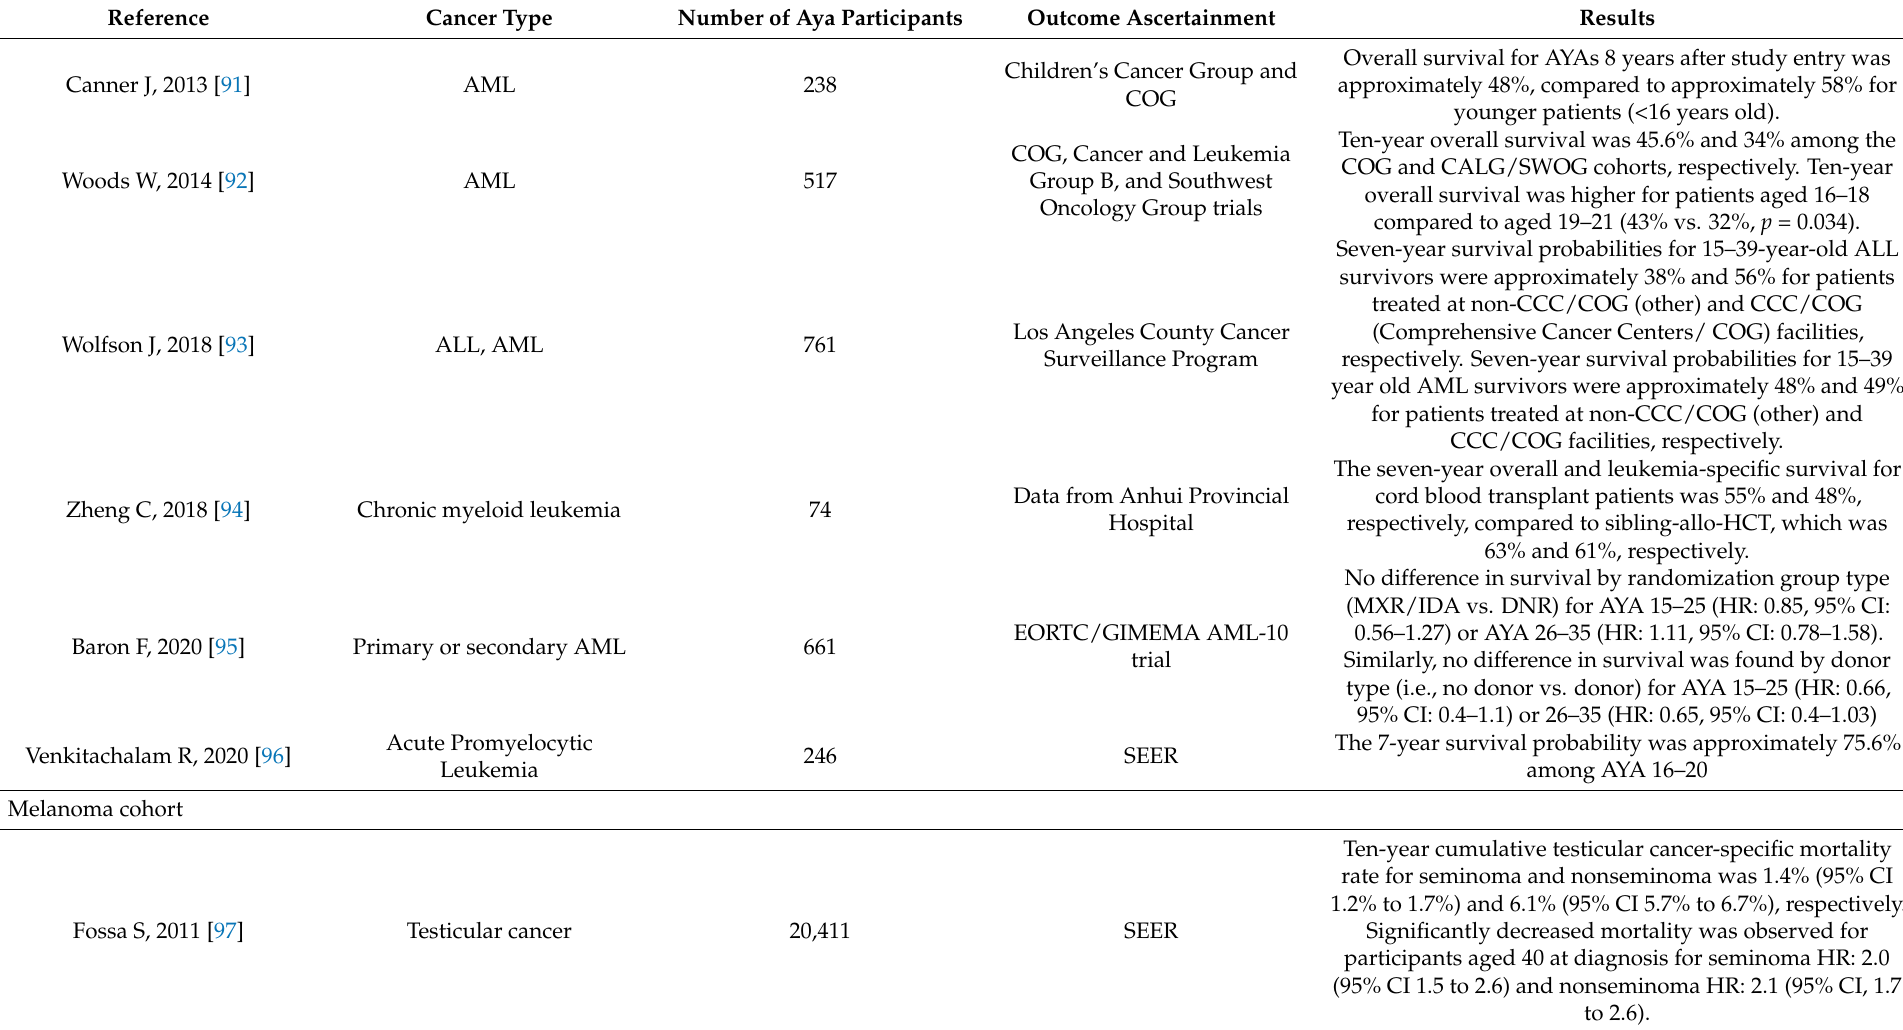
Ten-year cumulative testicular cancer-specific mortality rate for seminoma and nonseminoma was 1.4% (95% CI Significantly decreased mortality was observed for participants aged 40 at diagnosis for seminoma HR: